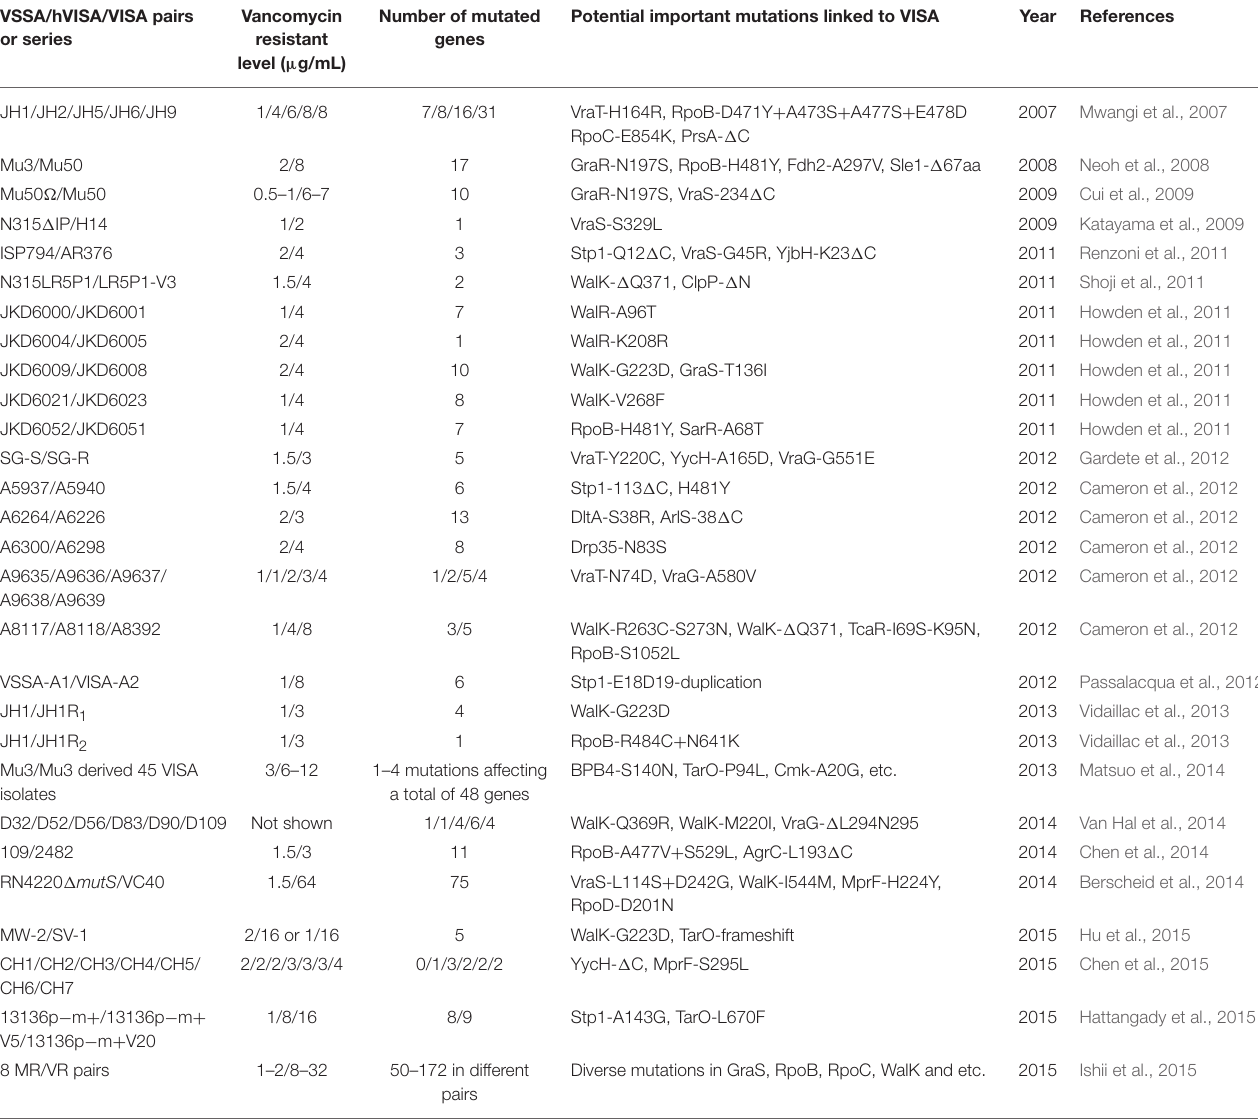
TABLE 1 | Mutations identified in hVISA/VISA strains comparied with the progenitor VSSA by whole genome sequencing. VSSA/hVISA/VISA pairs or